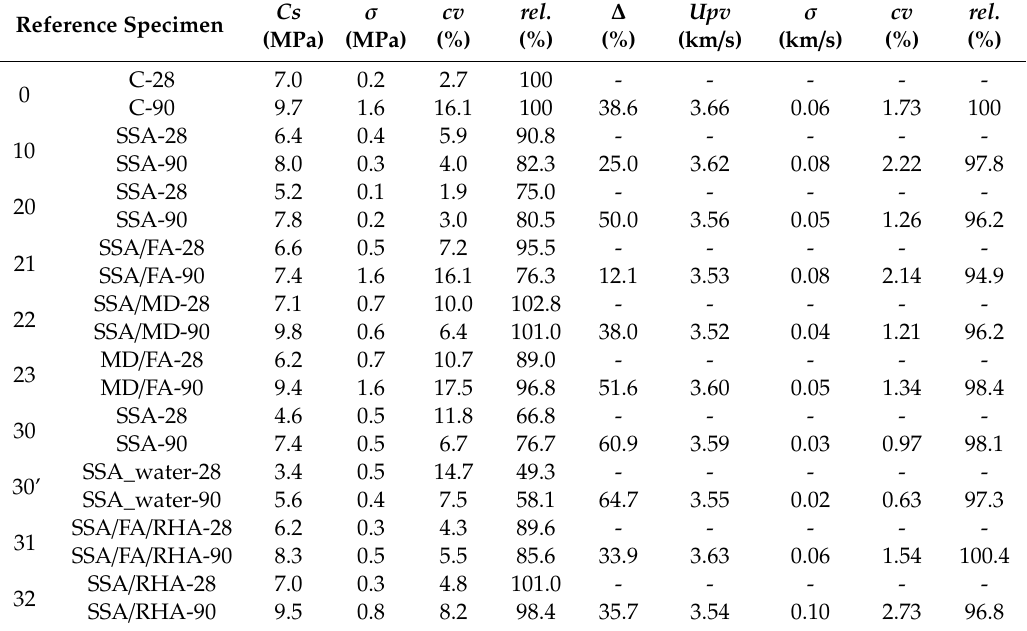
Table 6. Cs in specimens cured for 28 (from [37]) and 90 days and ultrasonic pulse velocity ( Upv ) in specimens cured for 28 and 90 days ( σ : standard deviation, cv : coe ffi cient of variation, rel : relative value compared to reference sample with same curing age, ∆ : increase in each mixture between the two curing